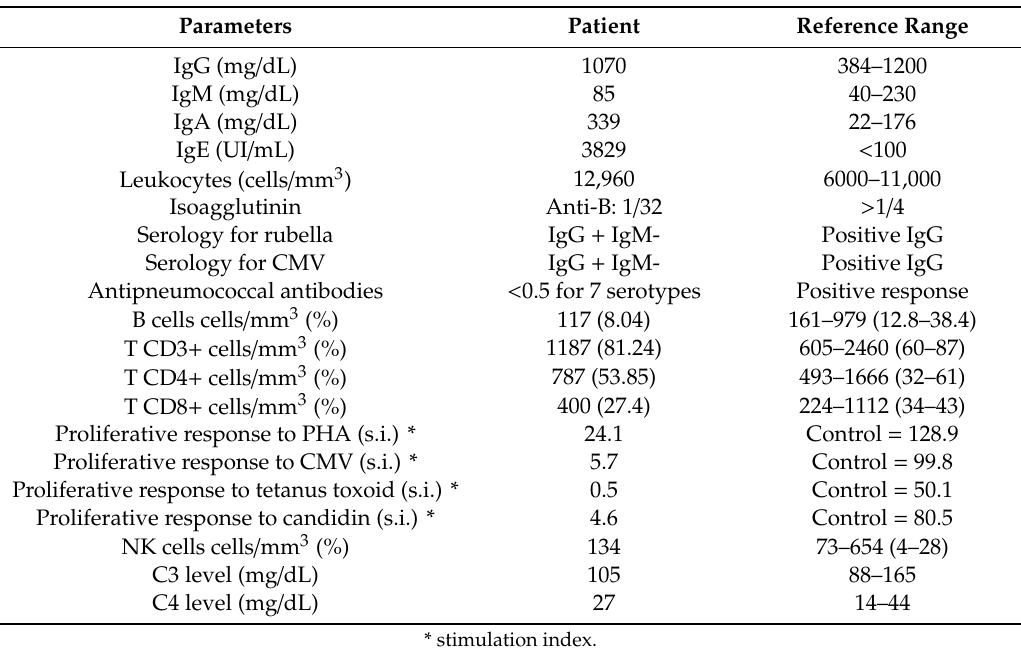
Table 1. Immunological evaluation of the patient with T. rubrum infection.